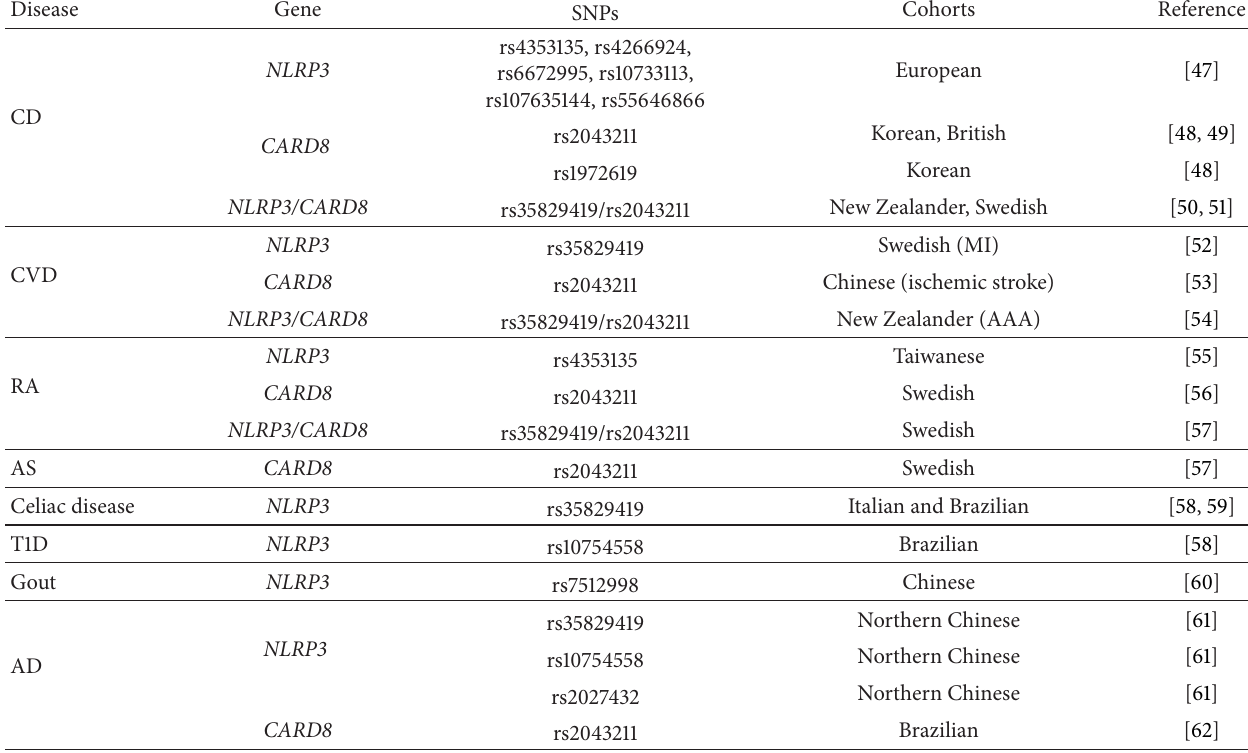
Table 1: Association studies confirming the role of NLRP3 and CARD8 gene polymorphisms in inflammatory disease.